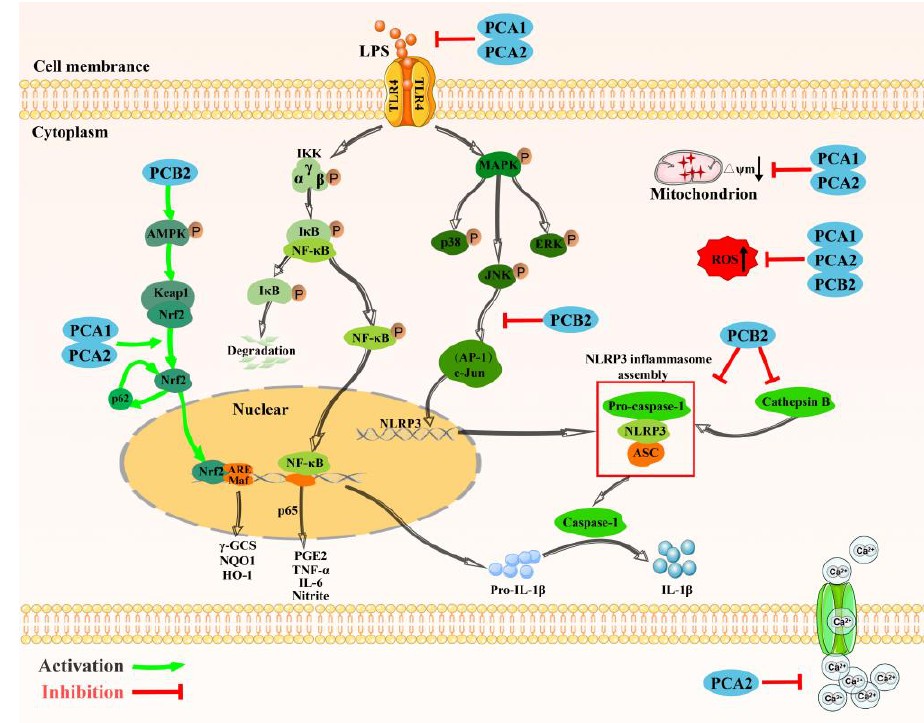
Figure 2. The anti-inflammation signal pathways of procyanidins. Notes: (1). Procyanidins activated the AMPK/Nrf2 pathway; targeted its downstream gene contributing to the increased level of antioxidant genes NQO1, HO-1 and γ -GCS. (2). Procyanidins inhibits the release of inflammatory factors IL-6, TNF- α , PGE2, NO through the I κ B/NF- κ B p65 pathway (Note: PCA1 show no effect of PEG2). (3). Procyanidins inhibit LPS activated AP-1/c-Jun pathway decreasing the gene expression of NLRP3, and suppress subsequent caspase-1 activation and the release of IL-1 β . (4). Besides, Procyanidins can also lower the production of ROS, reverse decreased mitochondrial membrane potential, inhibit Ca 2+ exclusion. Abbreviation: PCA1, procyanidins A1; PCA2, procyanidins A2; PCB2, procyanidins B2; AMPK, adenosine monophosphate-activated protein kinase; Nrf2, nuclear factor erythroid 2-related factor 2; NQO1, NAD(P)H quinone oxidoreductase 1; HO-1, heme oxygenase-1; γ -GCS, γ -glutamylcysteine synthetase; LPS, lipopolysaccharide; MAPK, mitogen-activated protein kinase; IKK, inhibitor of kappaB kinase; I κ B, nuclear factor kappa-B; NF- κ B, nuclear factor kappa-B; PGE2, prostaglandin E2; TNF- α , tumor necrosis factor- α ; IL-6, Interleukin-6; JNK, c-Jun N-terminal kinases; ERK, extracellular signal-regulated kinase; NLRP3, NOD-like receptor family pyrin domain containing 3; IL-1 β , Interleukin-1 β ; ROS, reactive oxygen